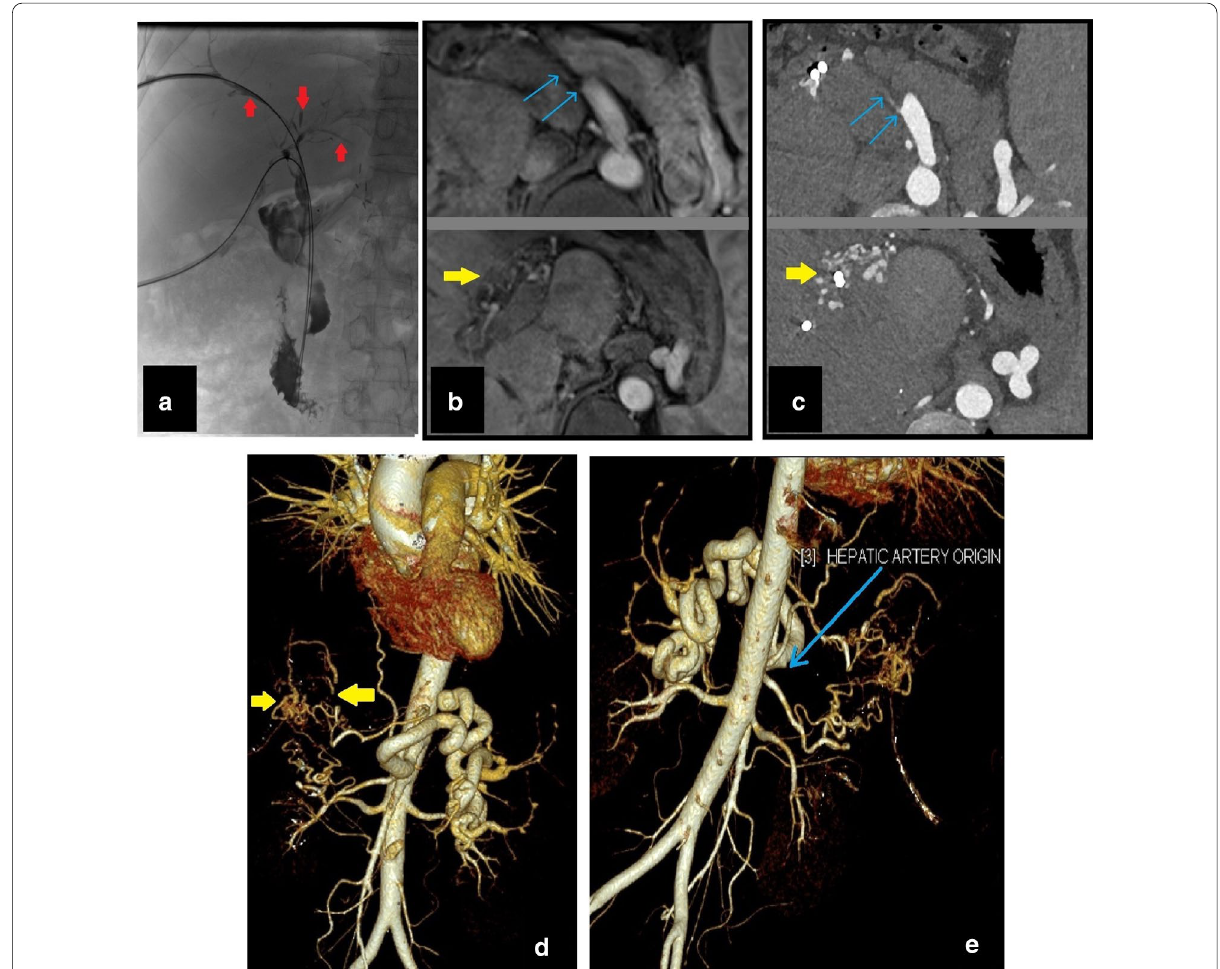
Fig. 22 Delay in diagnosis with no apparent harm. A 45-year-old male patient presented at the clinic with jaundice and recurrent cholangitis history after liver transplantation. Due to persistent itching and progressive jaundice, percutaneous transhepatic cholangiography (PTC) was performed for biliary drainage. PTC showed multisegmental involvement with dilated and stenotic biliary ducts (red arrows, a ). Contrast-enhanced upper abdominal MRI and MRCP for evaluation of the biliary tree were reported as “Chronic cholangiopathic changes due to recurrent episodes of cholangitis” without any differential diagnoses. The clinicians suspected "ischemic cholangiopathy" due to liver transplant history and ordered abdominal CTA to rule out ischemic etiology. The CTA, which was performed two weeks after MRI, revealed hepatic artery occlusion (blue arrows, c , e ) and arterial collateralization (yellow arrows, c , d ). After confirmation of “ischemic biliopathy”, the previous MRI was evaluated retrospectively. The MRI images ( b ) taken from the same slice levels of CTA ( c ) were less obvious to diagnose due to artifacts secondary to inadequate breath-holding. Higher spatial resolution with shorter imaging time of CTA enabled the radiologist to make an accurate diagnosis. As in this case, choosing the wrong technique or modality may decrease the possibility of detecting abnormal findings, cause a delay in diagnosis, and sometimes even make diagnosis impossible. However, in this particular case, the change in the diagnosis did not change the patient management to a great extent and did not cause any apparent